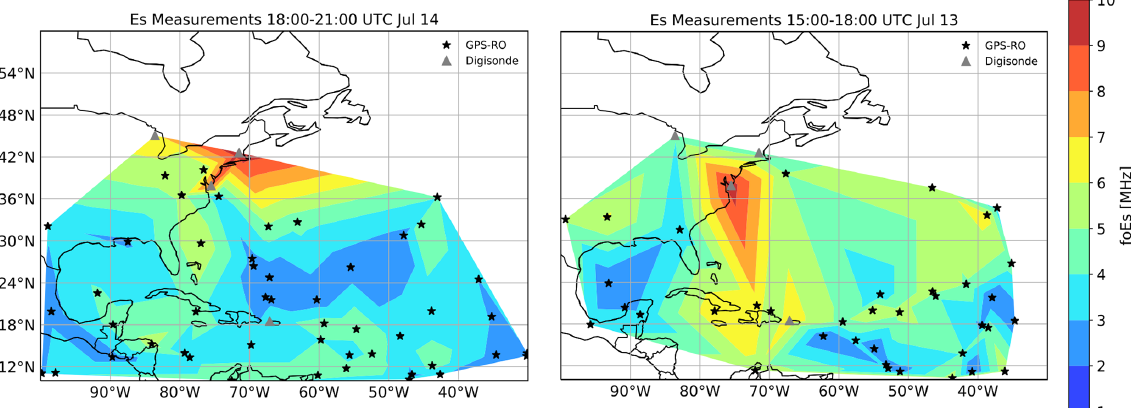
Figure 7. Figure 7 shows sporadic E maps based on Digisonde and COSMIC-2 RO S4 data for 18:00–21:00UT on 14 July 2021 and 15:00–18:00UT on 13 July